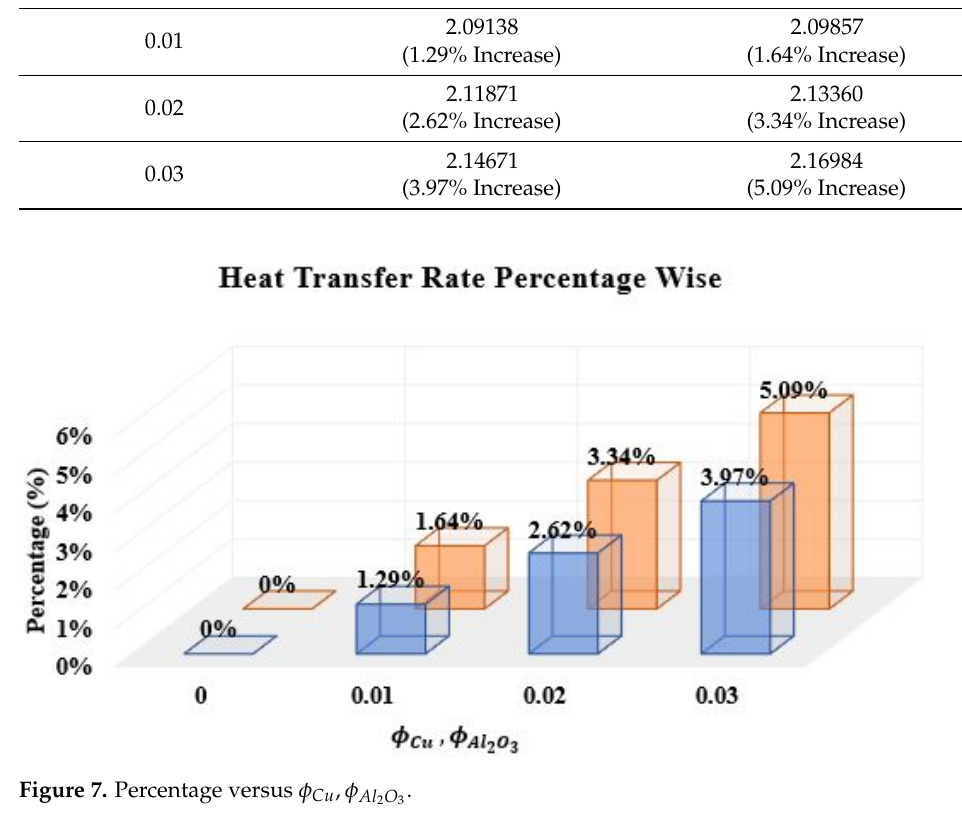
Figure 7. Percentage versus